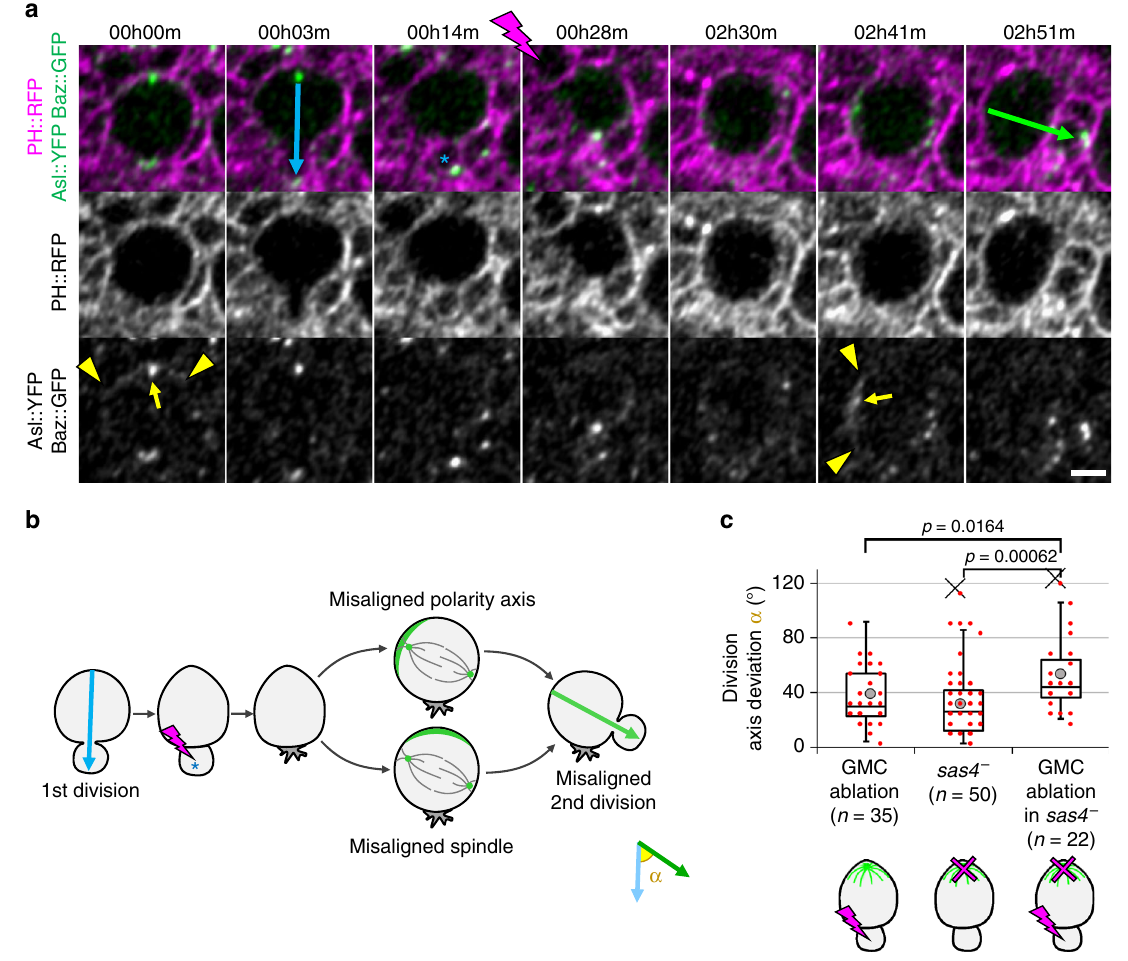
Fig. 3 Last-born GMC ablation displaces NB polarization. a Two successive divisions of NBs expressing the membrane marker PH::RFP (magenta), the apical marker Baz::GFP and the centrosome marker Asl::YFP (green) pre- and post-ablation. The ablation takes place between the two frames separated by a lightning symbol. Blue and green arrows: division axis. Yellow arrows: apical centrosome. Arrowheads: limits of Baz::GFP apical crescents. Blue asterisk: GMC prior to ablation. Data from two independent experiments. Scale bar: 5 µ m. b Schematic of the two possibilities explaining misaligned divisions following GMC ablation. Green crescent: apical pole. Grey lines: mitotic spindle. Green dots: centrosomes. c Deviation of the division axis following GMC ablation in control NBs (36 ± 20°, n = 35, also shown in Figs. 2c and 5c, data from ten independent experiments), no ablation in sas4 mutant NBs (33 ± 26°, n = 50, also shown in Supplementary Fig. 1d) and GMC ablation in sas4 mutant NBs (49 ± 28°, n = 22), data from six different